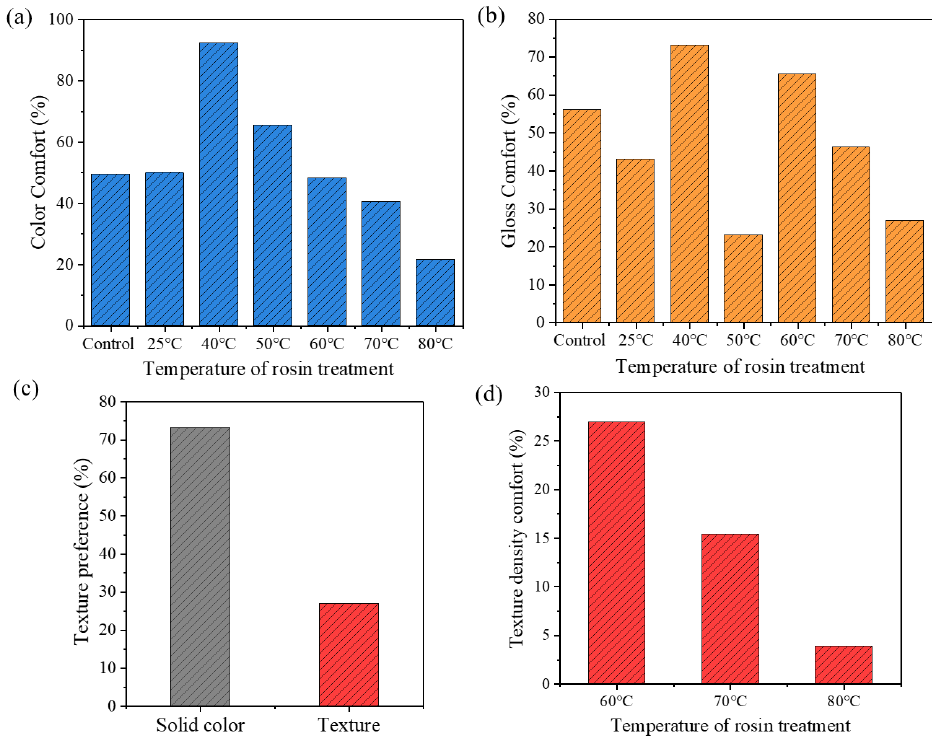
Figure 8. Subjective comfort evaluation results of color, gloss and texture preference of testees on bamboo culm surface. ( a ) color comfort; ( b ) gloss comfort; ( c ) texture preference; ( d ) texture density comfort.